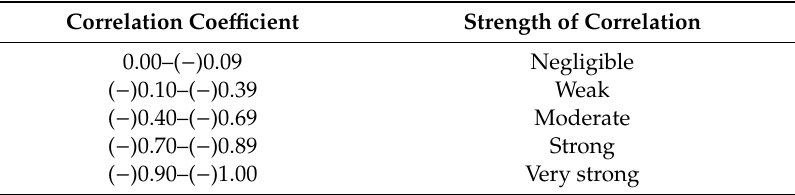
Table 1. Strength of correlation coe ffi cients according to [50,51].